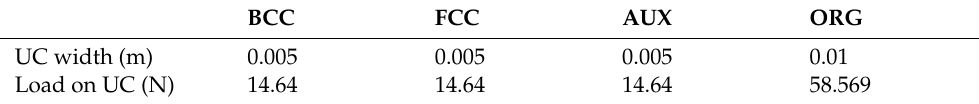
Table 4. Calculation of the load applied on the UC simulation, based on UC